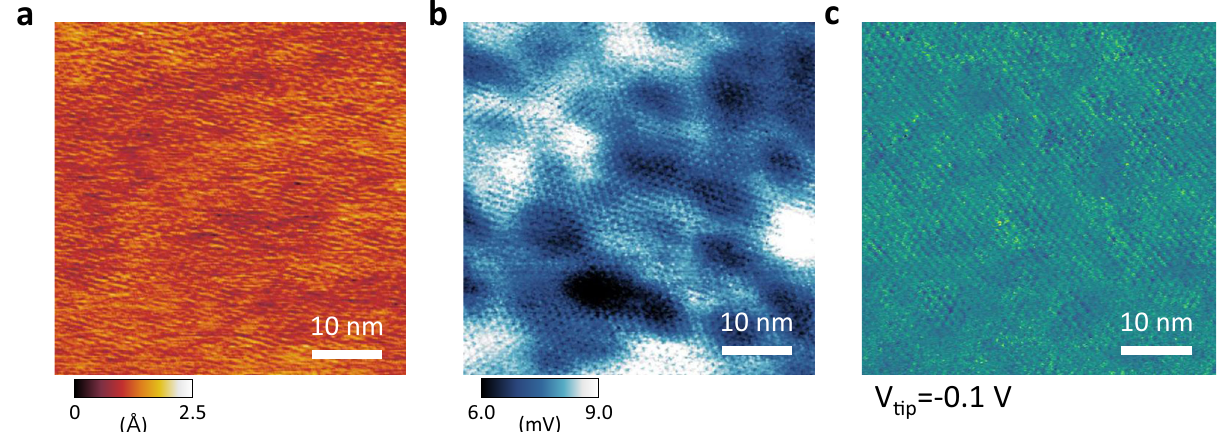
Fig. 3 | Thermopower and charge puddles in the commensurate CDW phase in 1T-TaS 2 bySThEMandSTM.a , b Topography a andthermopower b imagesovera distance of 100nm at T sample =78K. Despite the fl at nature of the topography in a , the thermopower fl uctuation shows a spatial variation of up to 3mV, which is distinct from charge puddles in 1T-TaS 2 . The bulk single crystal of our 1T-TaS 2